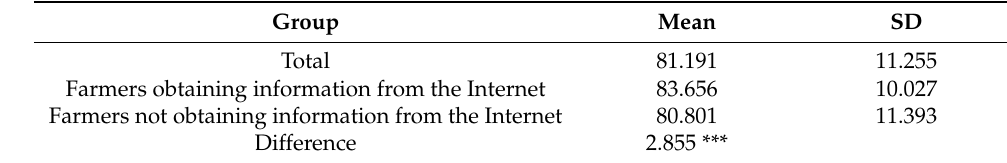
Table 4. Comparison of technical efficiency between farmers obtaining and not obtaining information from the Internet.